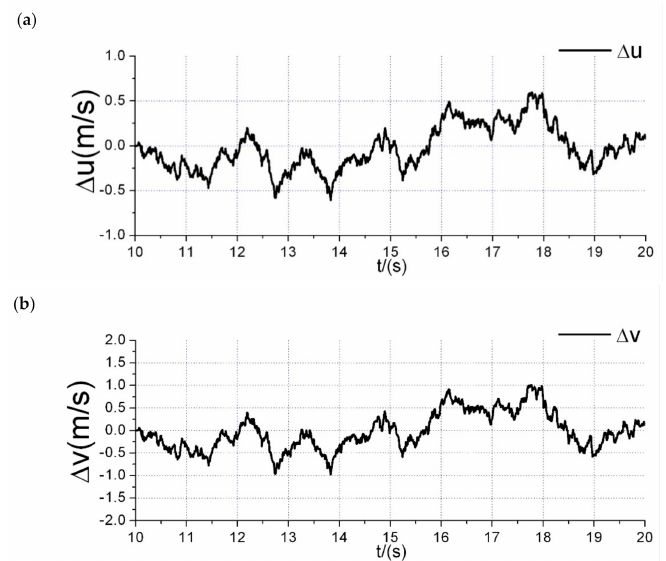
Figure 1. Wind gust based on Dryden spectral model. ( a ) Wind gust in longitudinal direction; ( b ) wind gust in lateral direction.